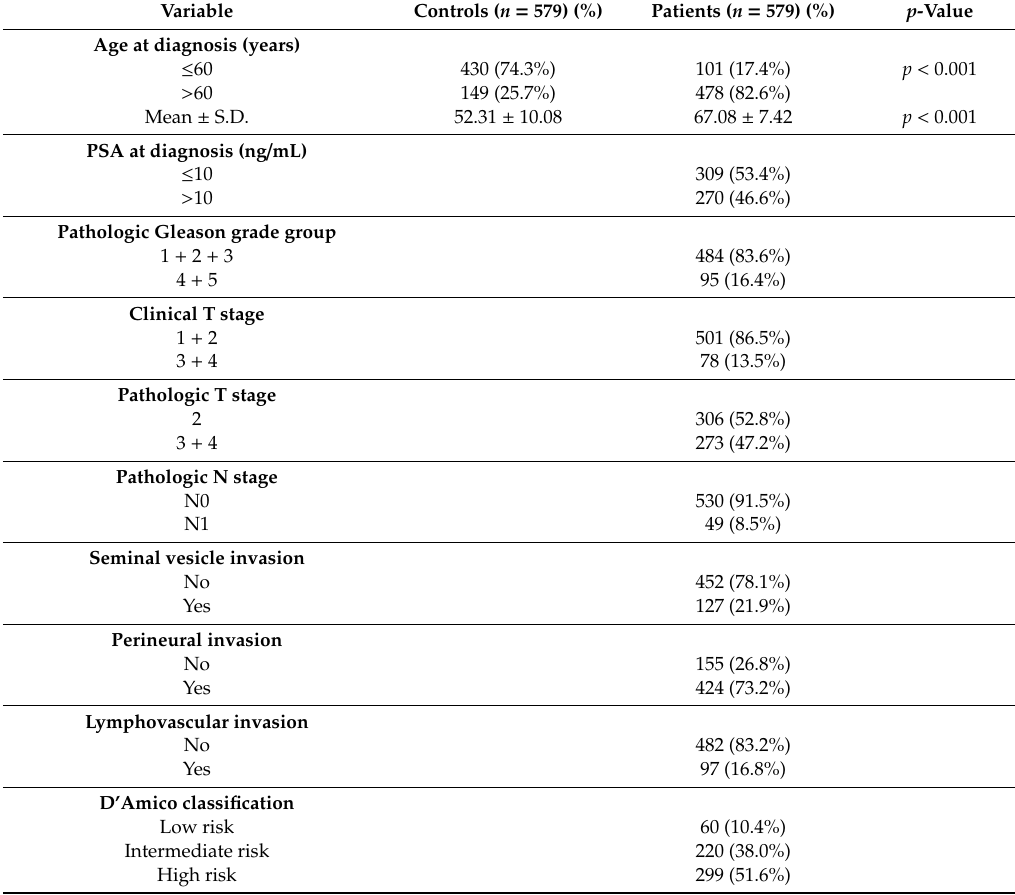
Table 1. The distributions of demographical characteristics in 579 control individuals and 579 patients with prostate cancer.